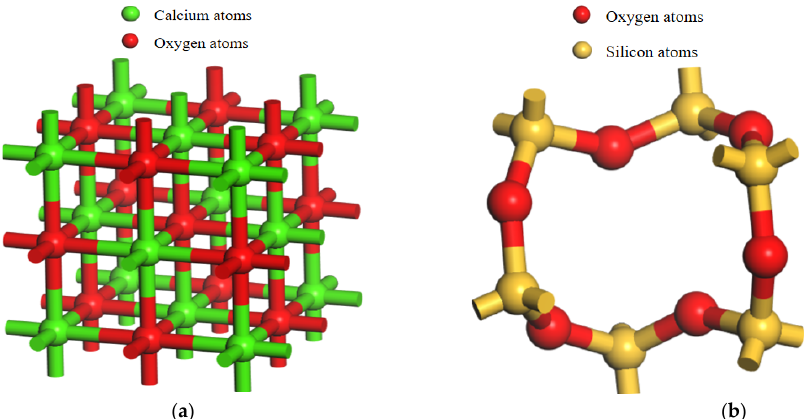
Figure 8. A crystal structure of calcium oxide and silica: ( a ) calcium oxide crystal cell; ( b ) silica crystal cell.